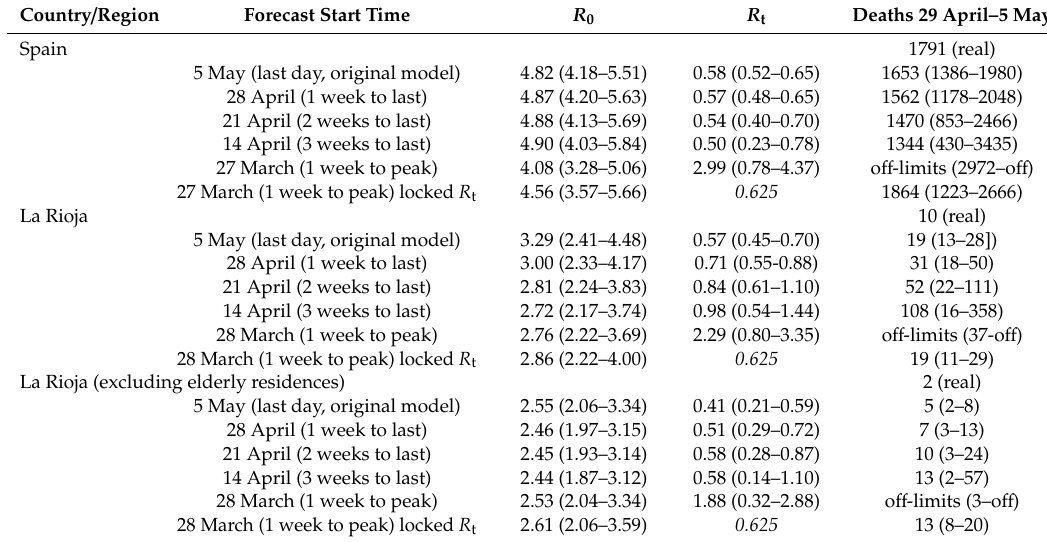
Table 5. Reproduction number and expected deaths during the last week of reported data (29 April–5 May) after removing di ff erent sets of dates from the